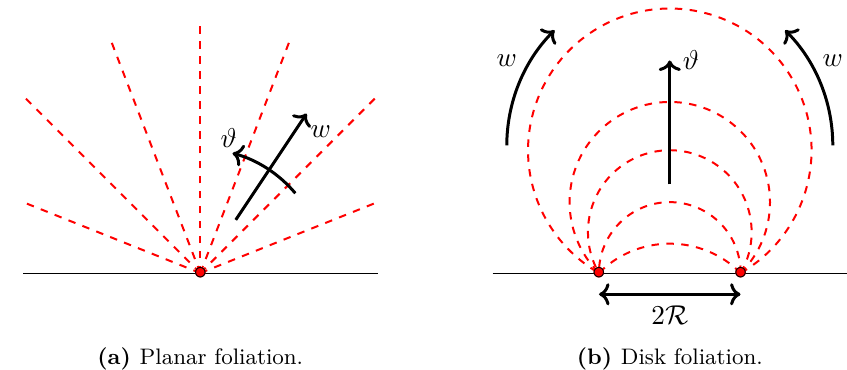
Figure 18. Transverse slices of (a) the planar foliation and (b) the disk foliation (labeled by R which represents the radius of the ( d − 1) -sphere on the boundary) of AdS d +1 . ϑ labels different AdS d slices, starting at 0 and ending at π . In the planar foliation, w = 0 is the conformal boundary of each individual slice, while w = ∞ is the Poincaré horizon of each slice. In the disk foliation, w = 0 is still the conformal boundary of each slice, but it reaches a finite maximum value of w = 2 R at the